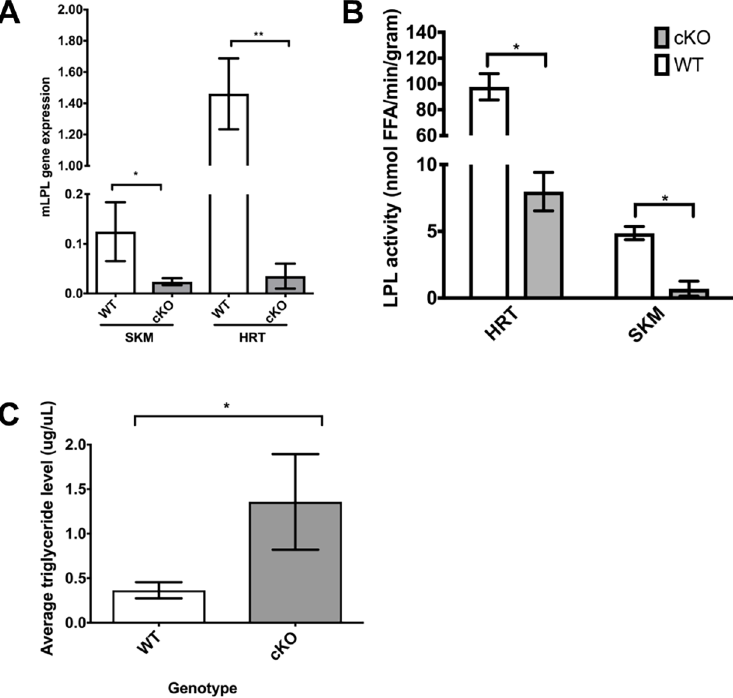
Fig 1. Striated muscle specific deletion of LPL leads to hypertriglyceridemia. A. Quantitative PCR for mouse LPL (mLPL) mRNA expressionin skeletal muscle (SKM) or heart (HRT) from wild-type(WT) and mck- Cre;lpl -/- (cKO) mice. Mouse LPL is virtually undetectable in cKO skeletal and cardiac muscles comparedto WT tissue ( * p < 0.02, ** p < 0.001;student’s T-test). Error bars representstandard deviation(SD). N = 3 for each genotype.B. Lipoproteinlipase enzyme activity in heart (HRT) and skeletal muscle (SKM) from wild-type (WT) and mck-Cre;lpl -/- (cKO) mice. LPL enzyme activity is significantly decreasedin cKO samples comparedto WT (p < 0.02;Student’s t-test). Error bars represent SD. FFA = free fatty acids. N = 3 for each genotype. C. Average fasting serum triglyceride levels from wild-type(WT) and mck-Cre;lpl -/- (cKO) mice. cKO mice have significantlyhigherfasting triglycerides levels than WT mice (p < 0.0001,Student’s t-test). Error bars represent SD. N = 3 for each genotype.